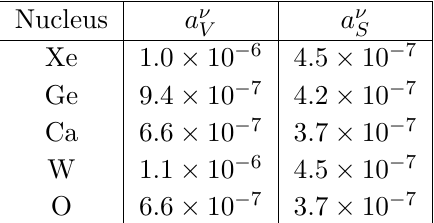
and a (cid:23) for various target nuclei, corresponding to strongest V S